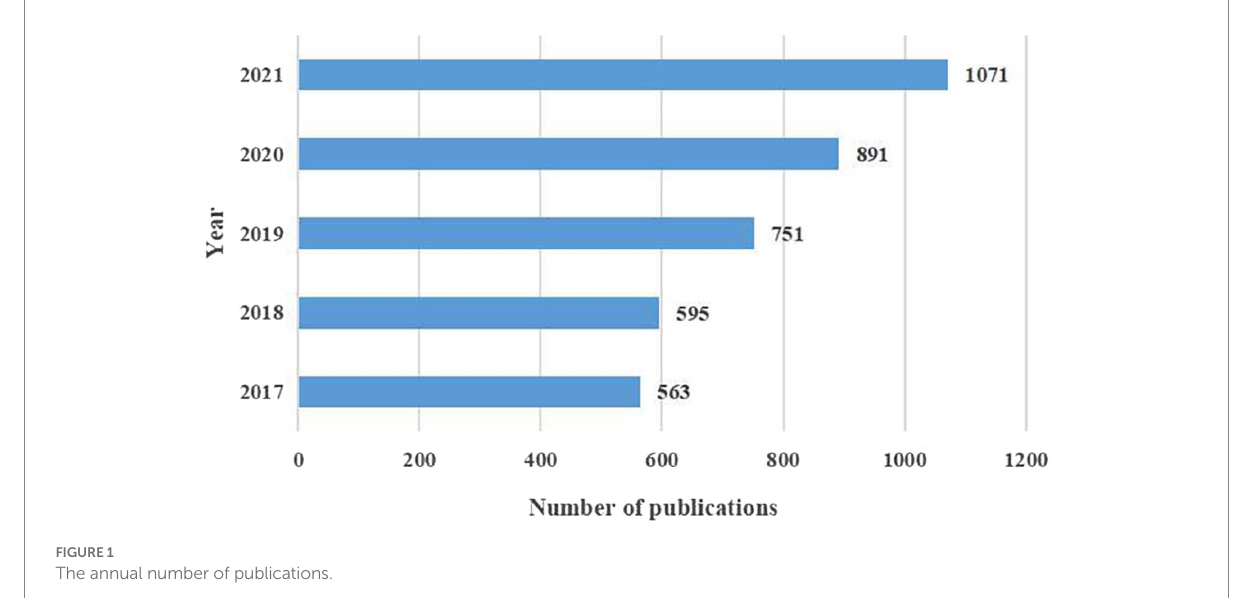
FIGURE 1 The annual number of publications.